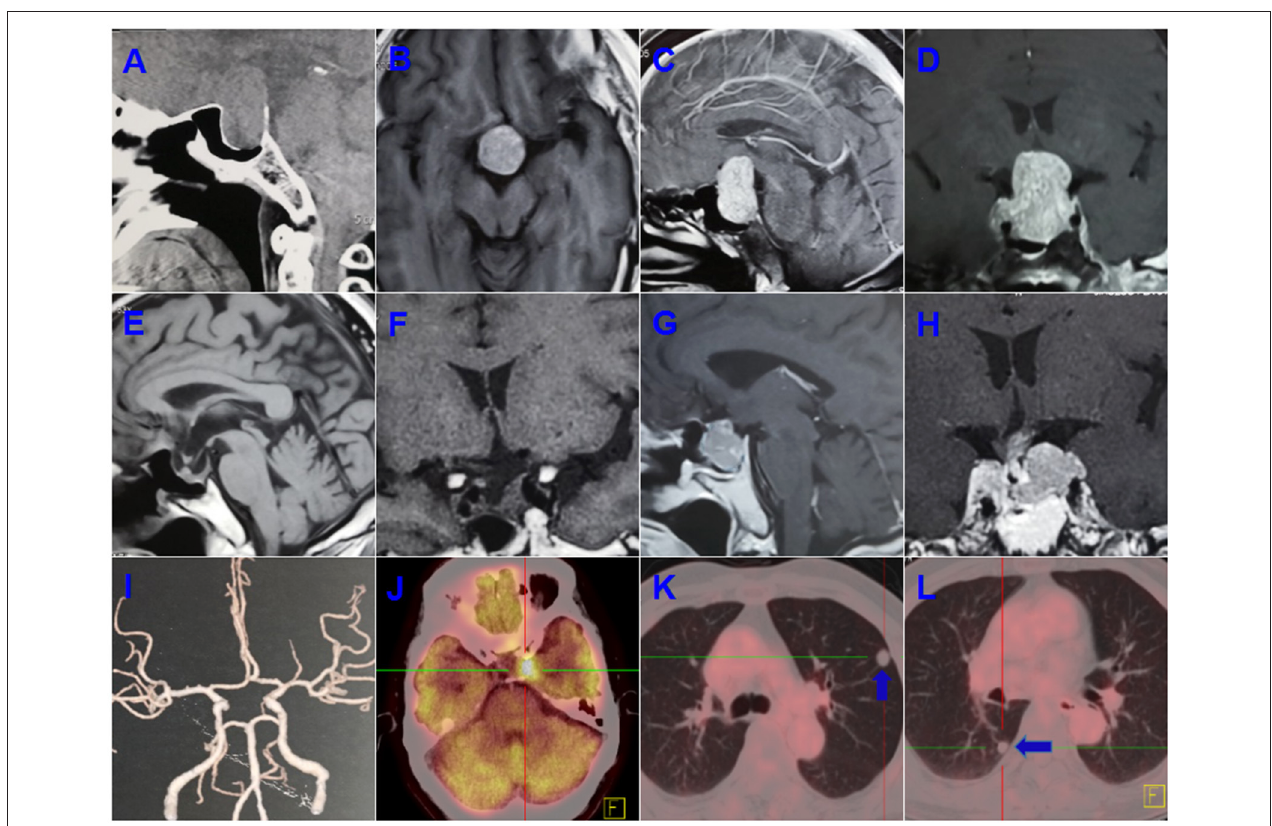
FIGURE 1 | Preoperative computed tomographic (CT) scanning revealed a large mass lesion in the sellar region (A) . Magnetic resonance imaging (MRI) also demonstrated a large lesion located in the sellar region, with heterogeneous enhancement and invasion to both cavernous sinuses (B–D) . Subtotal resection was obtained after operation (E,F) . A recurrent tumor was involved in the saddle fossa and left cavernous sinus (G,H) . Computed tomographic angiography (CTA) ruled out a left posterior communicating artery aneurysm (I) . The PET-CT showed a residual intracranial tumor in the left cavernous sinus after a second operation (J) . Multiple metastatic lesions were found in the lung ( K,L ; blue arrow indicates the metastatic